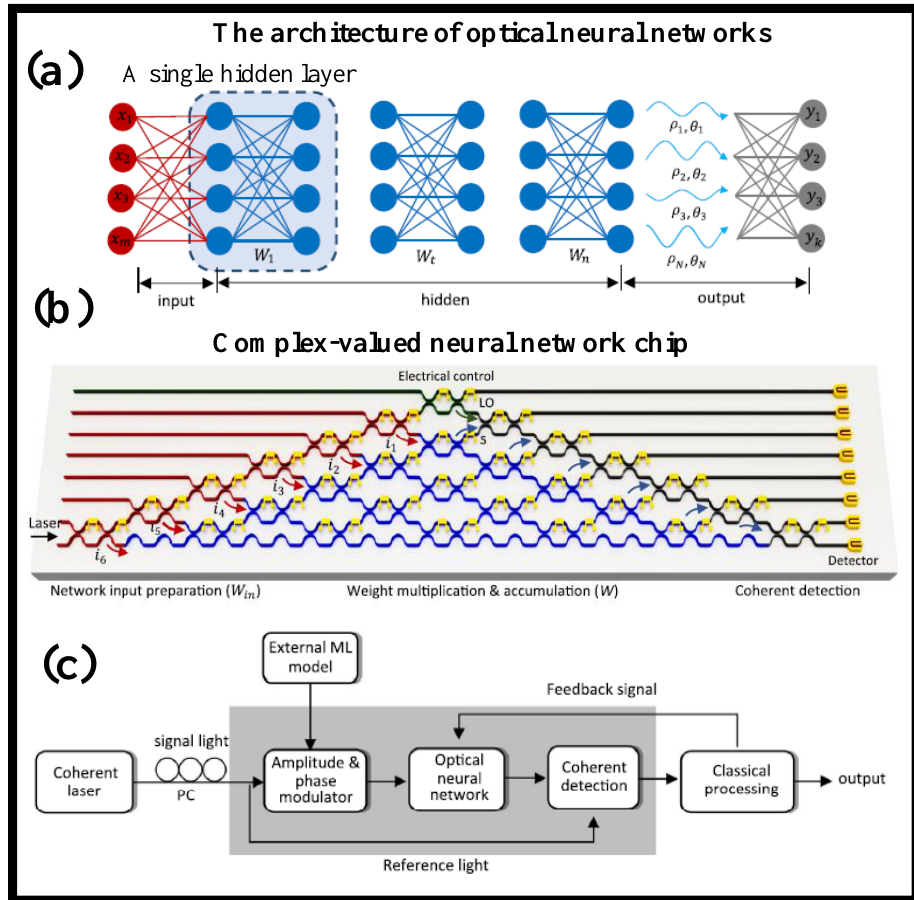
Figure 4. A complex-valued coherent optical NN’s composition. ( a ) An I/P layer, many hidden layers, and an O/P layer make up an optical NN. During the initial I/P preparation and network evolution, the light signals are encoded and modulated by both amplitude and phase in our complex-valued architecture [117]. ( b ) The ONC’s diagram for implementing complex-valued networks. On a single chip, I/P preprocessing, weight multiplication, and coherence recognition are all combined. The MZIs in red are responsible for the division and modulation of the light signals ( i 1 – i 6 ). The green MZI distinguishes the reference light that will be utilized for coherent detection later. Blue indicates the MZIs that were utilized to build the 6x6 complex-valued weight matrix. On-chip coherent tracking is established on the remaining gray designated MZIs [117]. ( c ) The ONC system’s process. Signal and reference light is generated using a 1550 nm coherent laser. The amplitude and phase of the signal light on each path are modified by the machine learning (ML) job. The light inference is used to perform the weighted sum process passively. The measurement findings are transferred to the electrical interface for processing, which includes activation function application and cost function computation. The modified weight matrices are then used to reprogram the ONC chip [117].